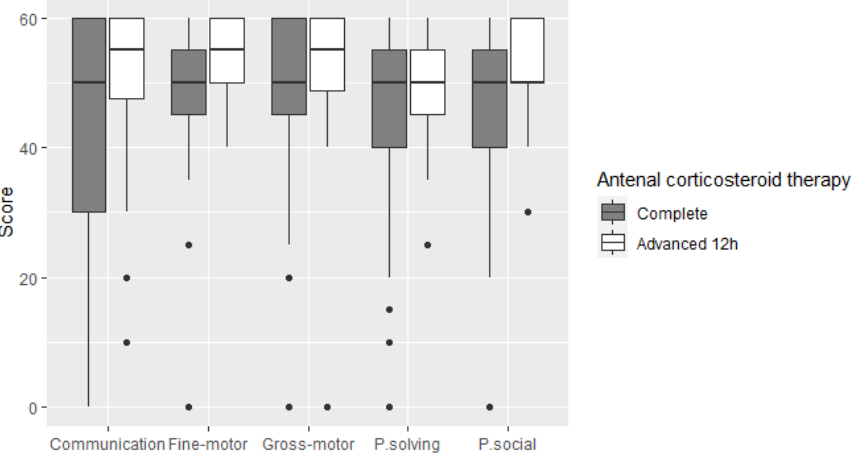
Figure 1. Distribution of the cohorts with respect to the ASQ ® -3 scale. P.solving, problem solving; P.social, Personal